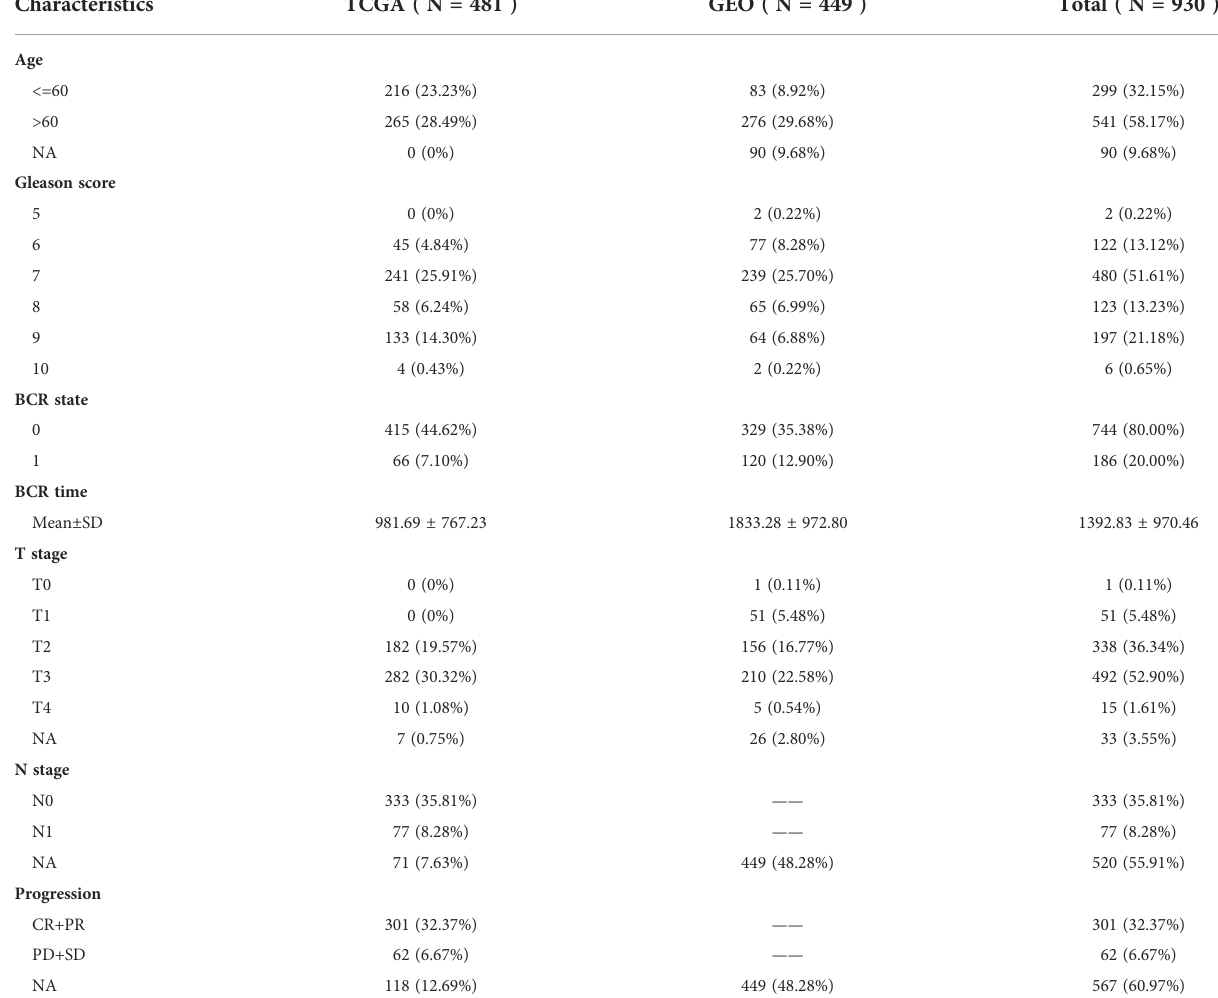
TABLE 1 Demographics and clinicopathological features of PCa patients in the TCGA and GEO cohort.